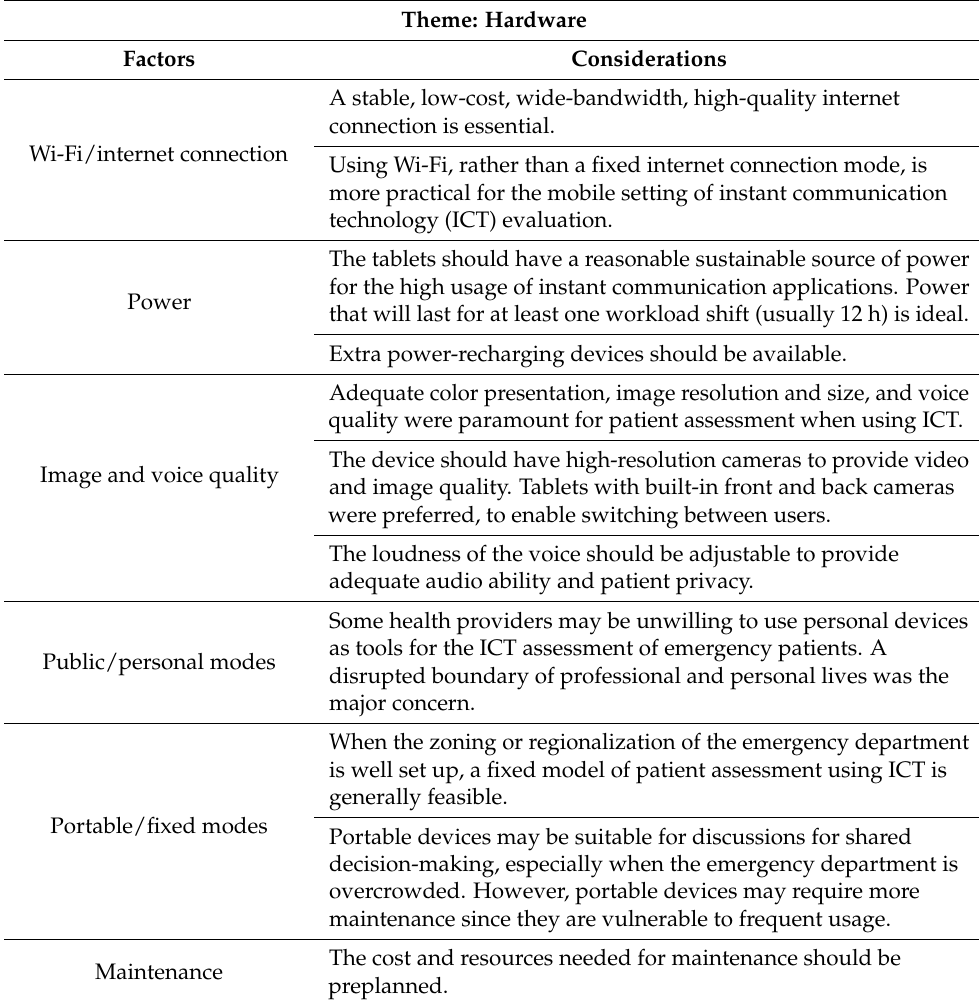
Table 2. Important considerations regarding the hardware when using instant communication technology for patient assessment in an emergency department.